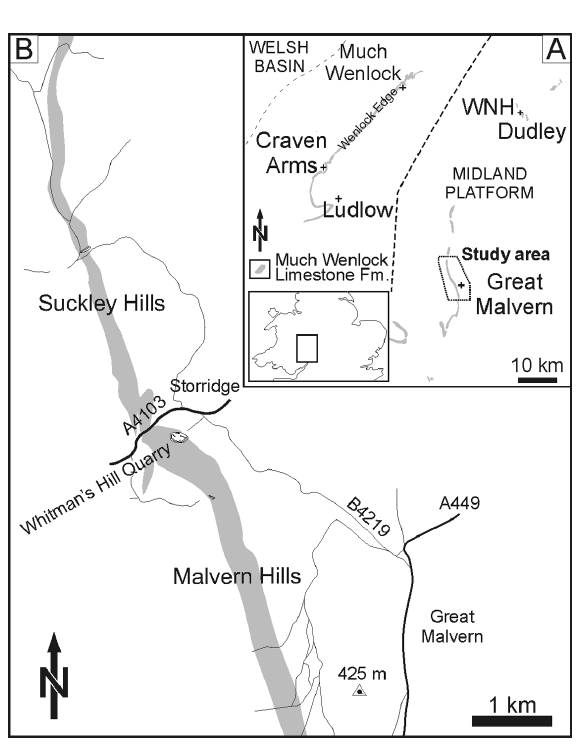
Fig. 1. Geographical position of Whitman(cid:146)s Hill Quarry. Grey areas mark outcrops of the Wenlock Series. A , position of the main outcrop belts of the Much Wenlock Limestone Formation in the western part of West Midlands. The dashed line marks the westernmost range of the Lower Quarried Limestone Member. The stippled line marks the area shown in B .